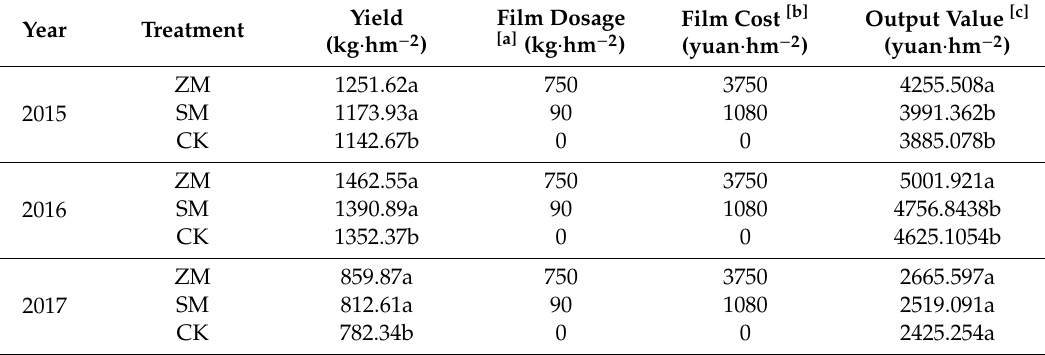
Table 2. E ff ect of di ff erent films mulching on rice